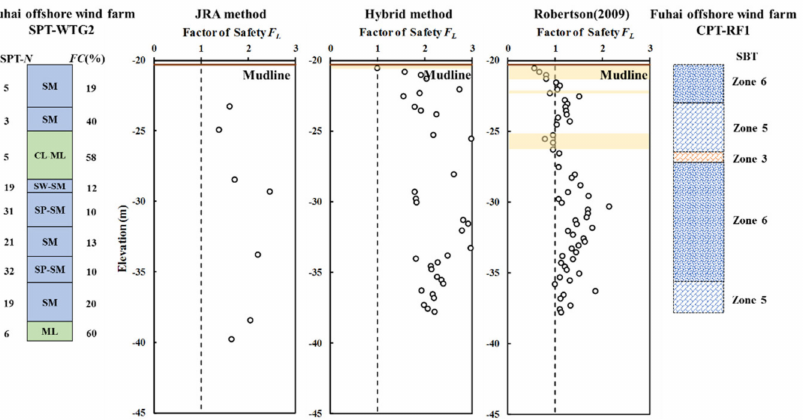
Figure 11. The soil liquefaction potential of boreholes CPT-RF1 and SPT-WTG2 in Fuhai offshore wind farm.